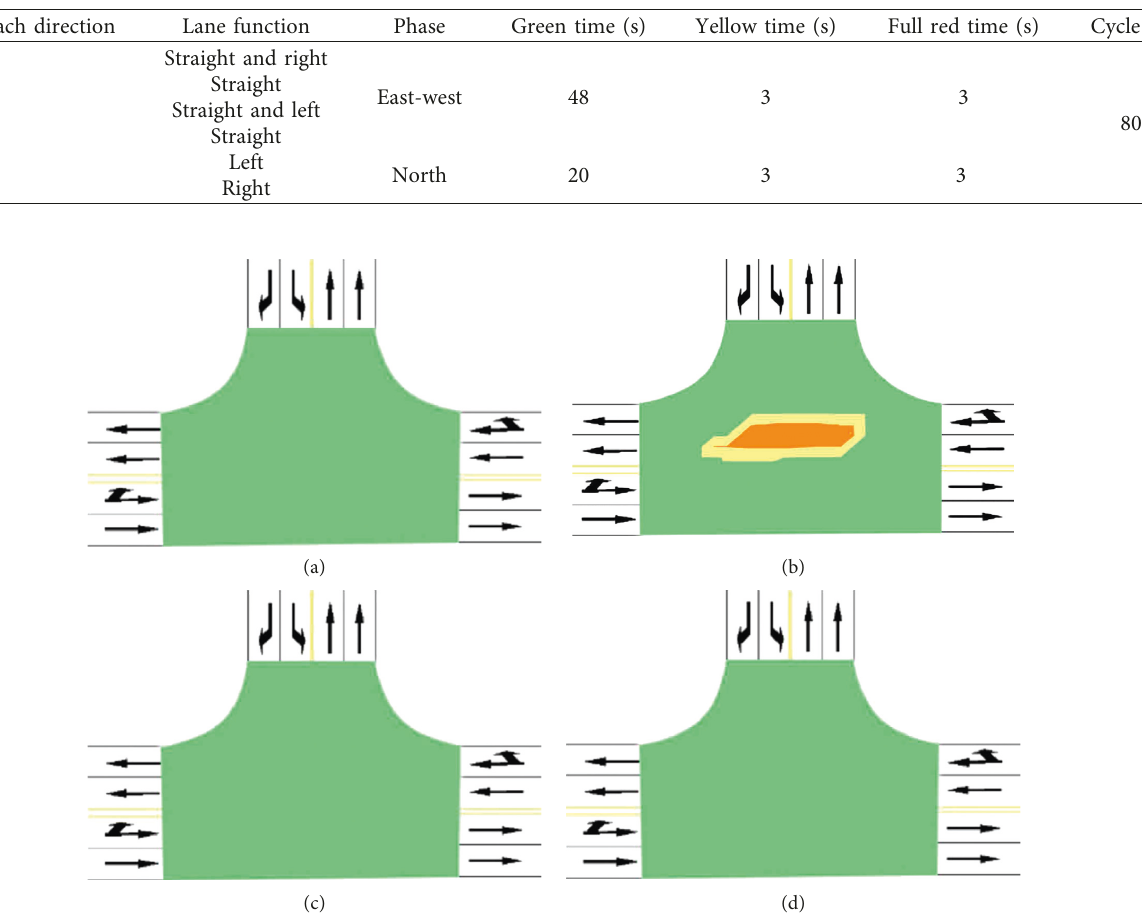
Figure 8: The heat map of conflict probability of intersection in different phases under signal timing optimization strategy. (a) Phase 1. (b) Phase 2. (c) Phase 3. (d) Phase